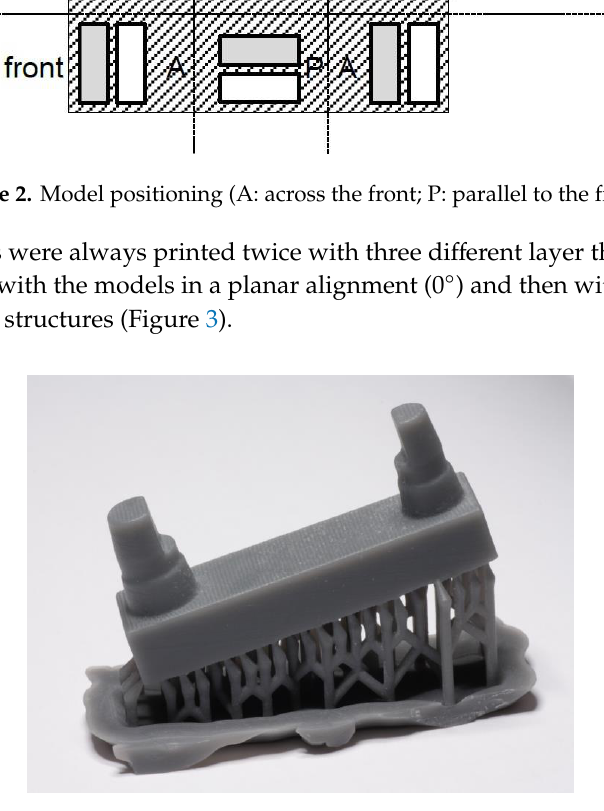
Figure 3. Printed model, with a layer thickness of 100 µm, angulated with a support structure. Altogether, 12 printing processes were executed (D1–D12). Each printing process generated ten models aligned across the printer front (A) and eight models aligned parallel to the printer front (P). The synthetic Grey Resin V3 (FormLabs Inc.) was used for all printing processes. Table 1 summarizes